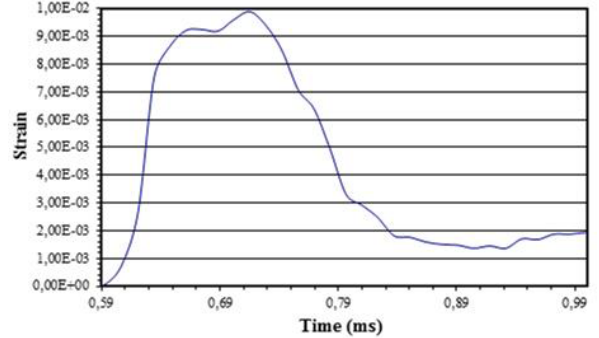
Figure 15. Strain-time curve in the centre of the SiC-reinforced ZC71 magnesium alloy specimen pertinent to the modified SHTB including an interruption device (Model 3) when using 0.5mm thick lead damping rings at − 7000mms − 1